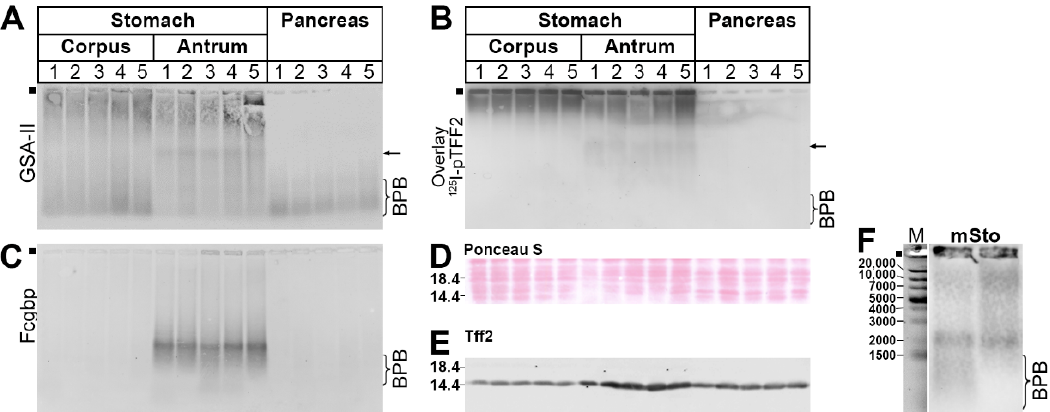
Figure 9. Western blot analysis and in vitro binding study. 1% AgGE and Western blot analysis of TRIzol extracts from 5 different samples (30 µg protein per lane) of the murine gastric corpus, gastric antrum, and pancreas, respectively ( A – C ). ( A ) Analysis concerning Muc6 (lectin GSA-II); arrow: antrum-specific signals. ( B ) Overlay assay with 125 I-pTFF2; arrow: antrum-specific signals. ( C ) Analysis concerning Fcgbp. ( D , E ) Loading controls of the same samples after reducing SDS-PAGE: protein staining with Ponceau S ( D ) and Western blot concerning Tff2 ( E ), respectively. ( F ) Controls: Relative standard: DNA ladder (base pairs), murine gastric extracts (before SEC and fraction B9 from Figure 2; analysis concerning Fcgbp). The start (dot) and the dye bromophenol blue (BPB) are marked.